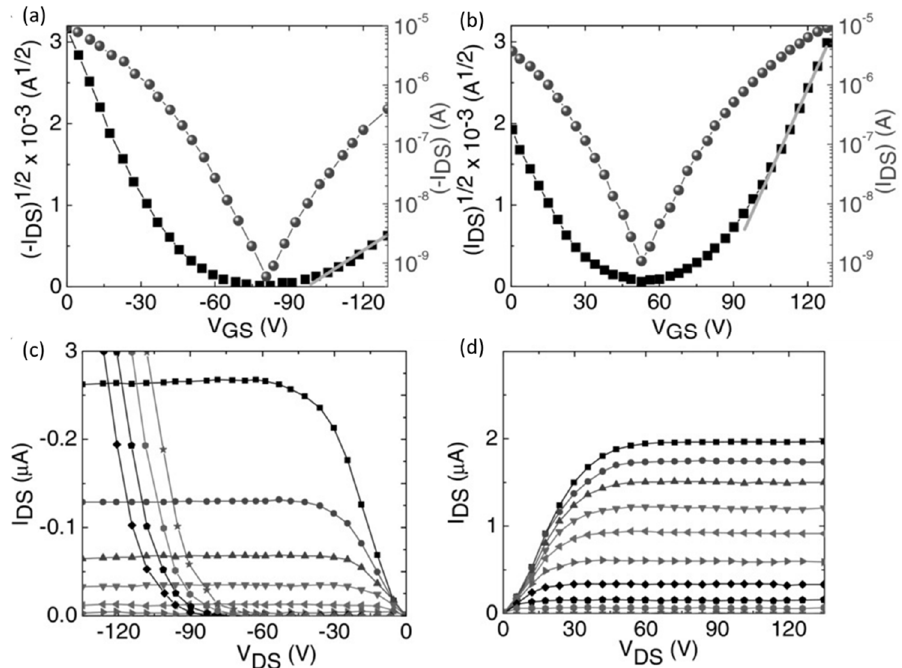
Figure 5. The transfer characteristic curves of the ( a ) p-channel and ( b ) n-channel hybrid perovskite-channel-based ambipolar FET. The output characteristics ( c ) p-channel and ( d ) n-channel of a triple cation perovskite-channel-based ambipolar FET. Reproduced with the permission from [76]. Copyright 2016 WILEY-VCH Verlag GmbH & Co. KGaA, Weinheim.